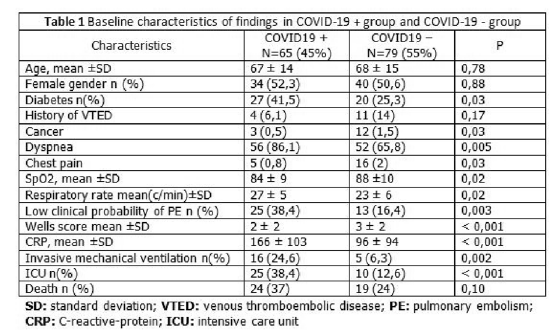
1 Baseline characteristics in COVID-19